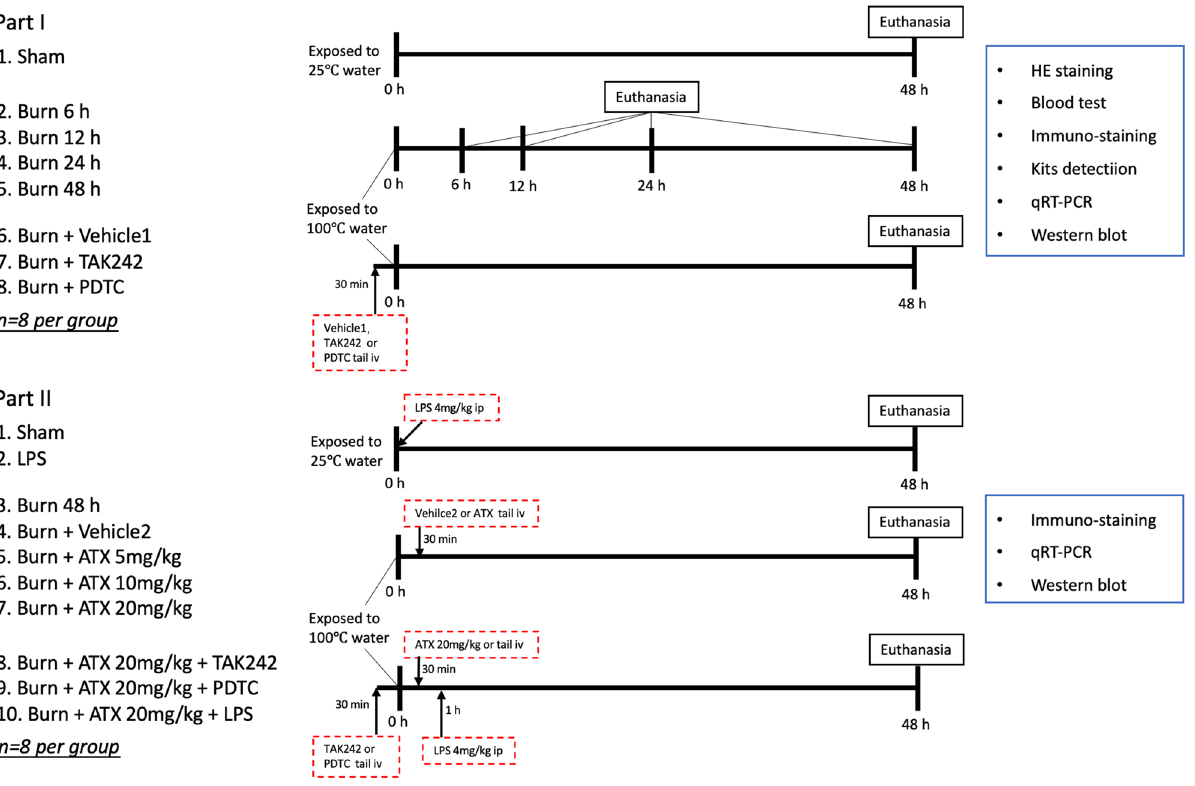
Figure 9. The experimental design and